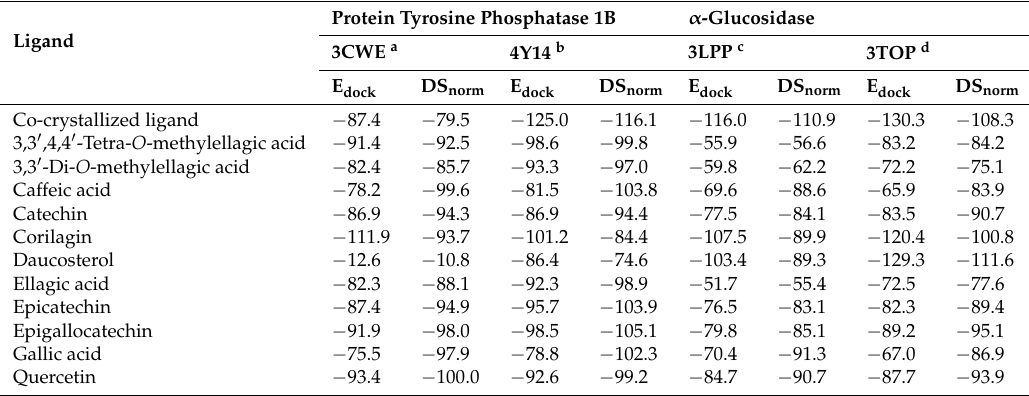
Table 3. Molegro docking energies (re-rank scores, E dock ) and normalized docking scores (DS norm ), kJ/mol, for Geranium collinum phytochemicals with human protein tyrosine phosphatase 1B and human α -glucosidase.